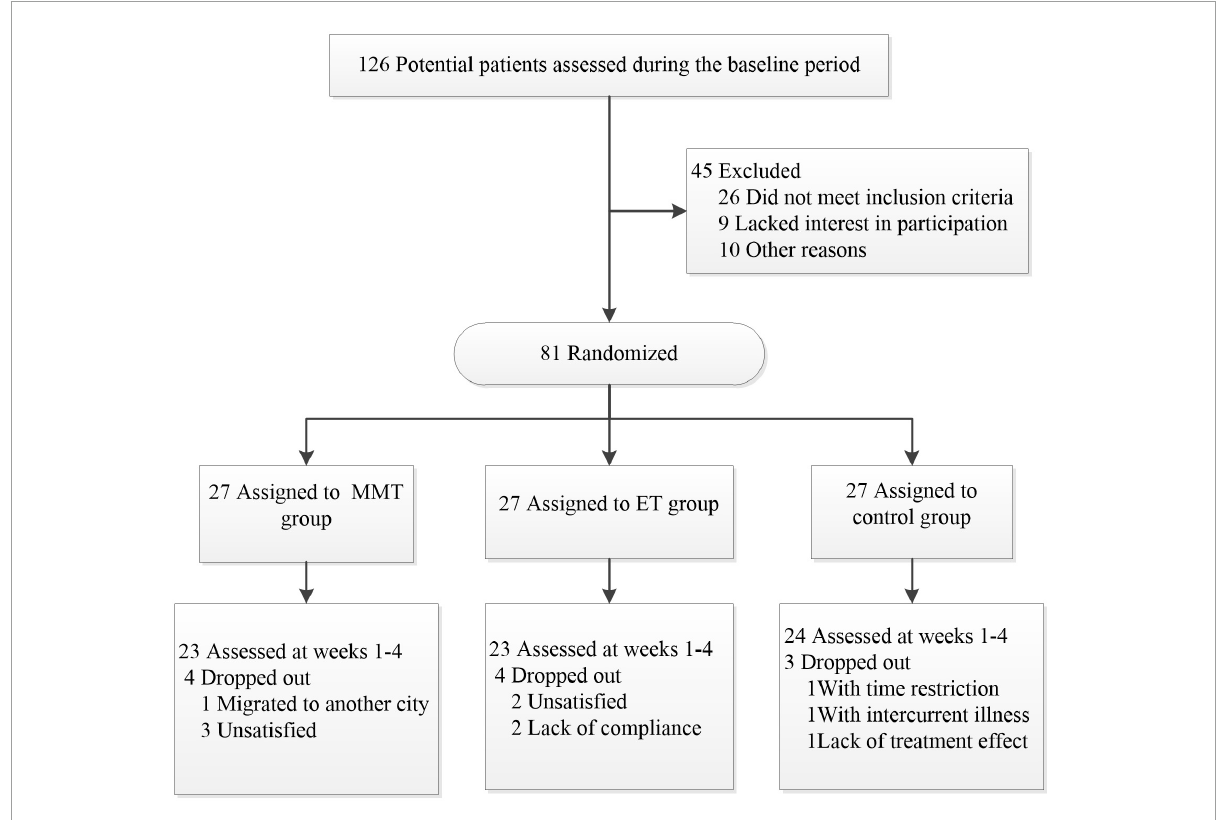
FIGURE1 Flowchart of the screening, enrollment, and